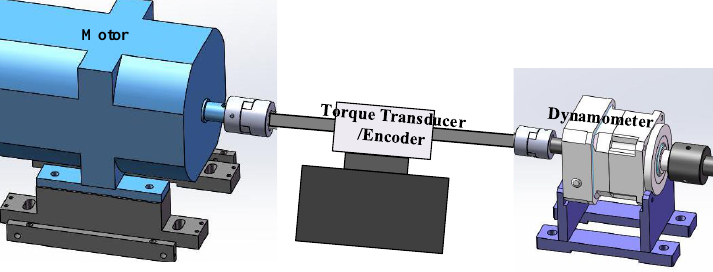
Figure 12. The schematic diagram of bearing experimental platform of Case Western Reserve University. In this case, the wavelet basis function we choose is db6, and the number of wavelet layers is l = 3. The experimental environment, experimental parameters, selection of train- ing set and test set, selection of comparison model, and evaluation criteria of Section 5.2 are the same as Section 5.1, except that wavelet function, wavelet packet scale, and the selected data